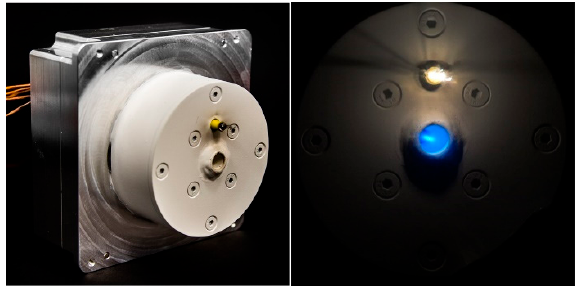
Figure 7. Micro-newton cusped field thruster developed by Airbus.